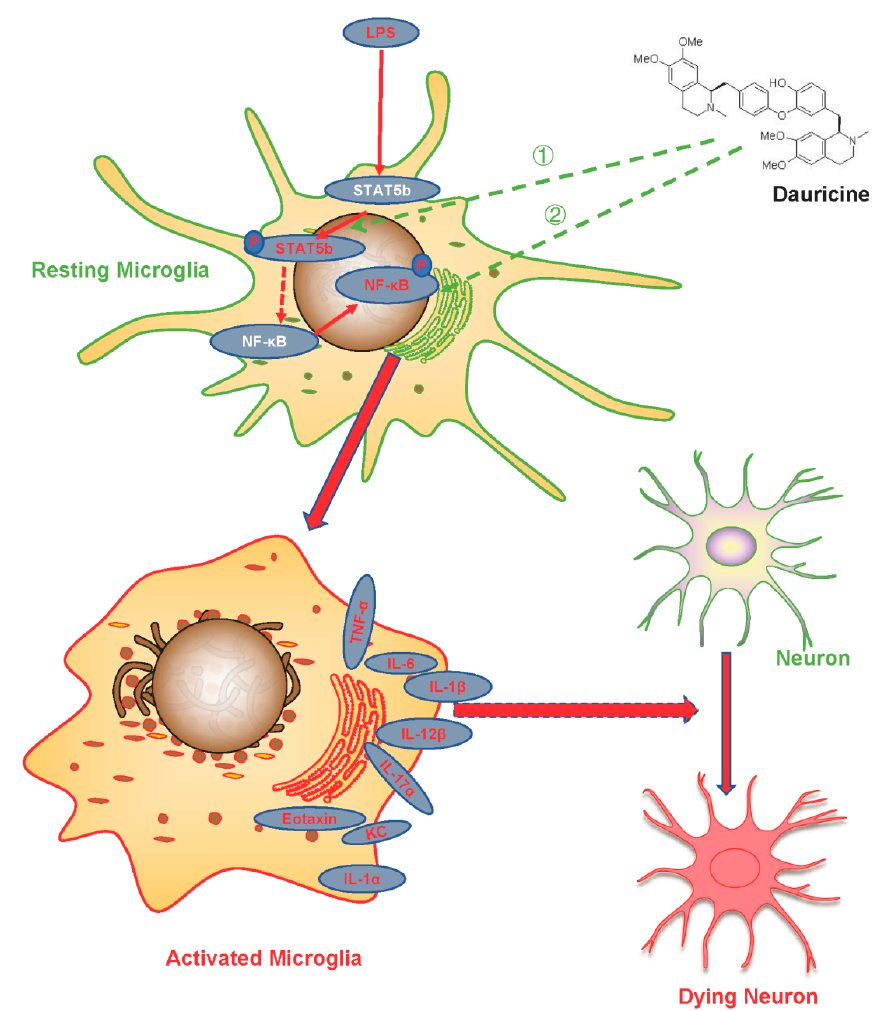
Figure 8. Schematic diagram of the mechanisms underlying the role of dauricine on regulating the microglia activation and protecting neurons from ischemia-reperfusion injury.